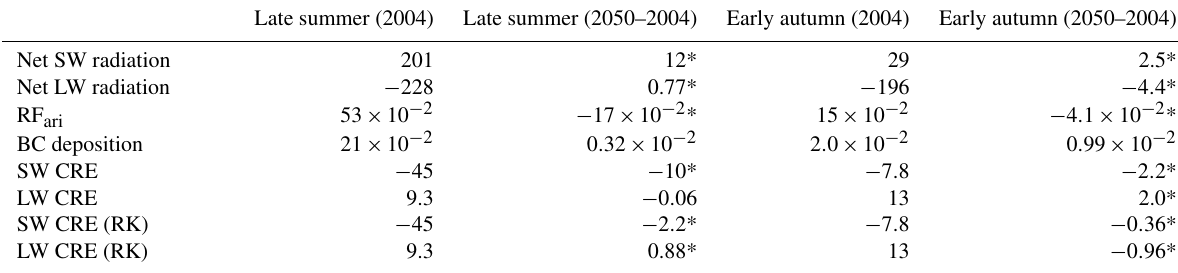
Table 5. The same as Table 4 but averaged over all latitudes north of 75 ◦